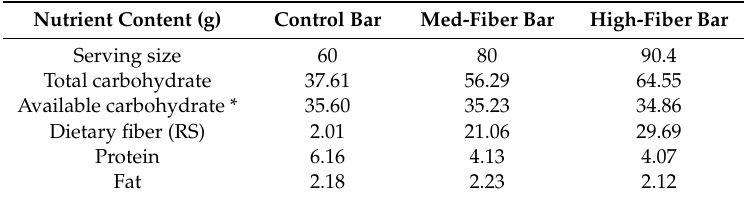
Table 1. Nutrient composition of control and test bars.